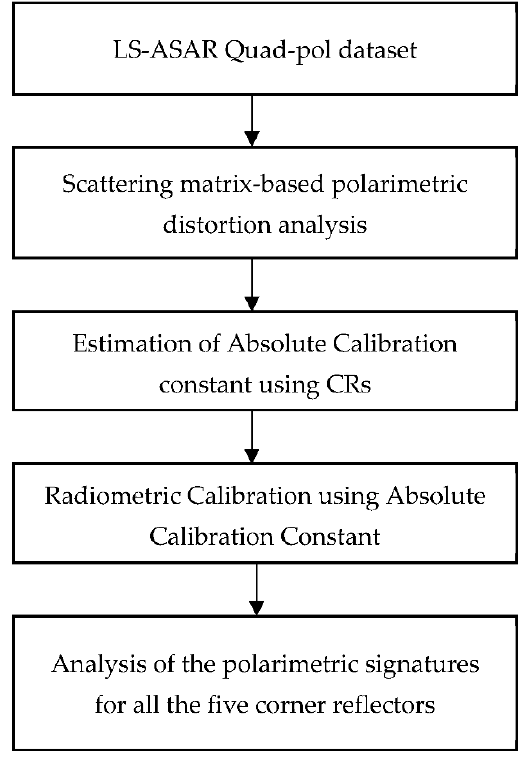
Figure 2. The methodology of the LS-ASAR polarimetric distortion analysis.